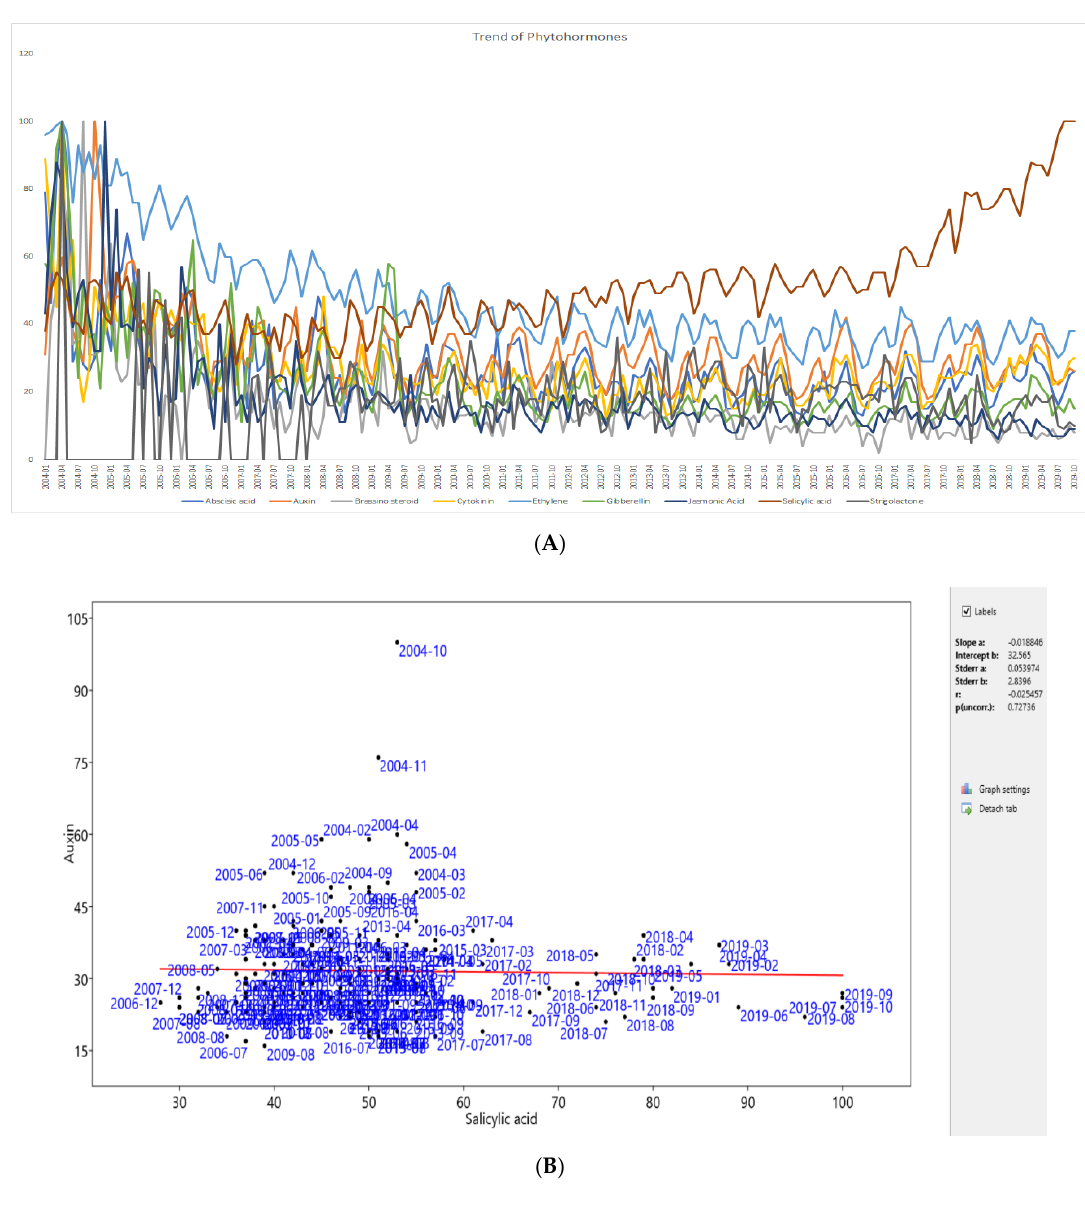
Figure 2. ( A ) Trends of phytohormone search queries from January 2004 to October 2019. The trend shows the search query for salicylic acid is continuously growing compared to other phytohormones. The search query for strigolactones was very low. In total, nine phytohormones, namely abscisic acid, auxin, brassinosteroids, cytokinin, ethylene, gibberellin, jasmonic acid, salicylic acid, and strigolactones were taken into consideration. ( B ) Regression analysis of salicylic acid with auxin showed negative correlation (y = 51.708 − 0.034x, slope a = − 0.018, r = − 0.025). The regression analysis of salicylic acid with other phytohormones are provided in Supplementary Figure S3.